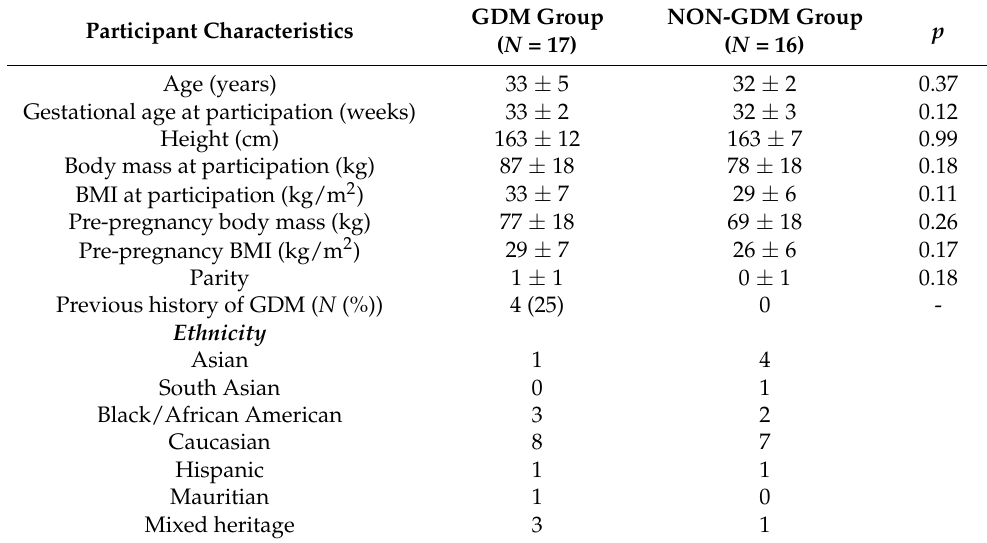
Table 1. Participant